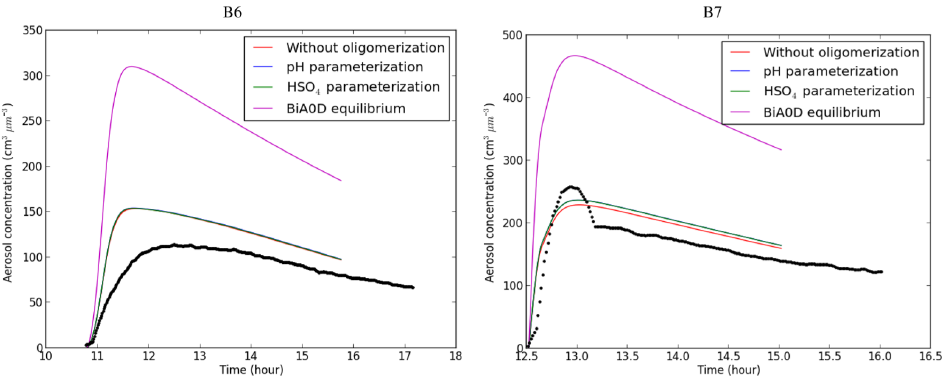
Figure 8. Aerosol concentration formation for the biogenic experiments with SO 2 . Black lines correspond to SMPS measurements.